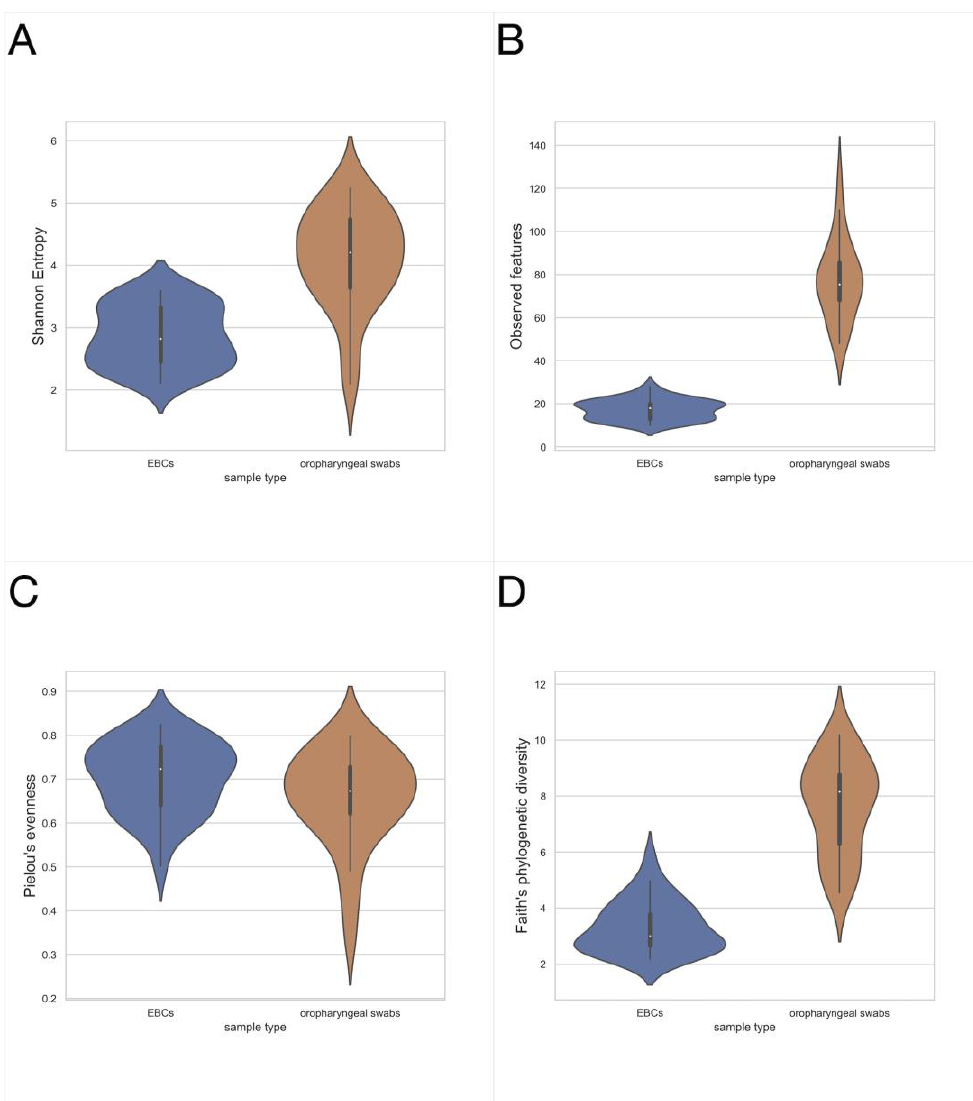
Figure 1. Alpha diversity metrics for sample type, asthmatic patients, and healthy controls taken together. ( A ) Shannon diversity index, mean 4.112 (±0.794) vs. 2.867 (±0.481), p = 9.108 × 10 − 8 ; ( B ) Observed Features, mean 77.4 (±18.1) vs. 17.3 (±4.4), p = 5.572 × 10 − 11 ; ( C ) Pielou’s evenness, mean 0.657 (±0.109) vs. mean 0.703 (±0.083), p = 0.109; ( D ) Faith’s Phylogenetic Diversity, mean 7.686 (±1.672) vs. 3.280 (±0.829), p = 1.296 × 10 − 10 swab ( n = 26) vs. EBC ( n = 33), respectively, Kruskal – Wallis test.